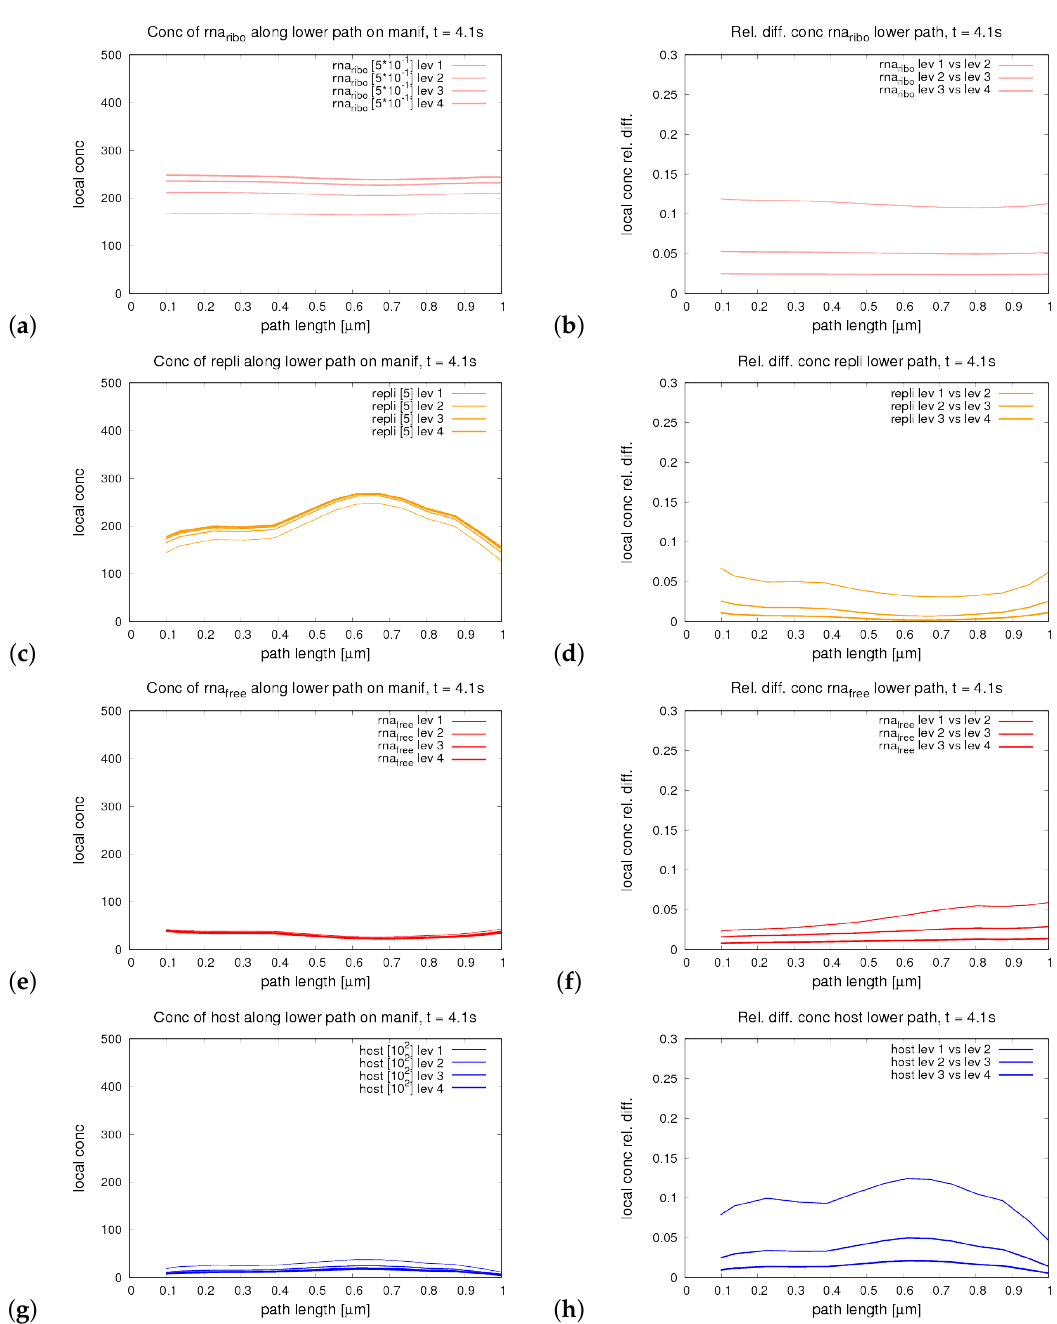
Figure A4. Variation of spatial refinement level for the 1D profiles of the concentrations around a web region. Lower sub path part one. Concentrations of HCV RNA containing components and of host factor. ( a ) Ribsomal bound RNA absolute values for different grid refinement levels, ( b ) ribsomal bound RNA relative differences for different grid levels, ( c ) Replication complex absolute values, ( d ) replication complex relative differences, ( e ) free RNA absolute values, ( f ) free RNA relative differences, ( g ) host factor absolute values, ( h ) host factor relative